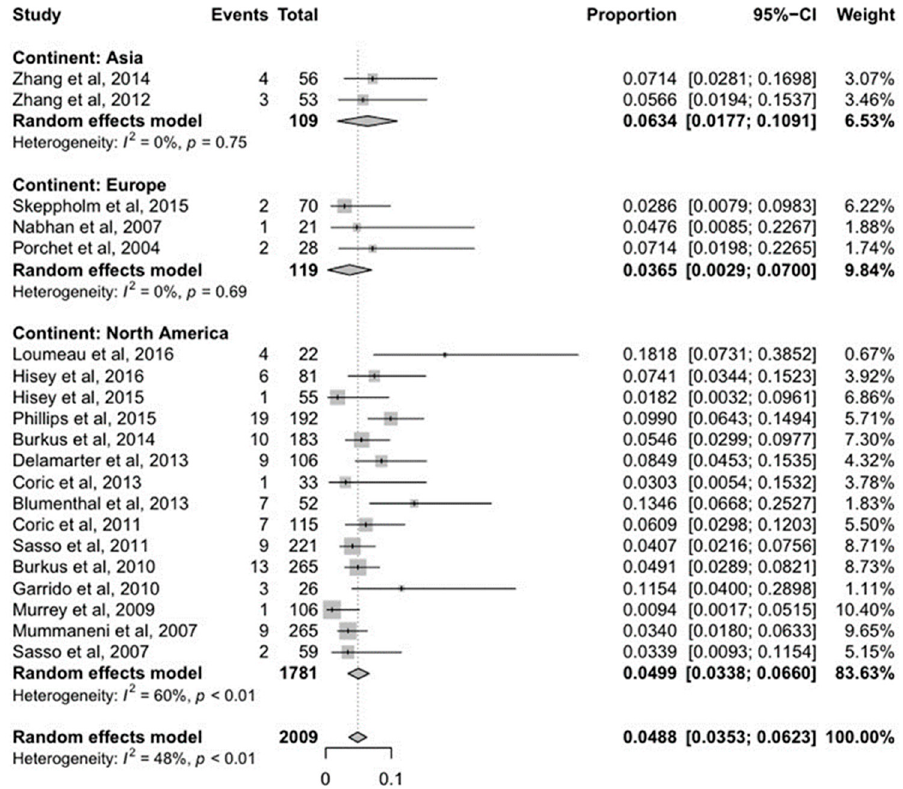
Figure 2. Forest plot comparing cASP that underwent surgery among the continents.